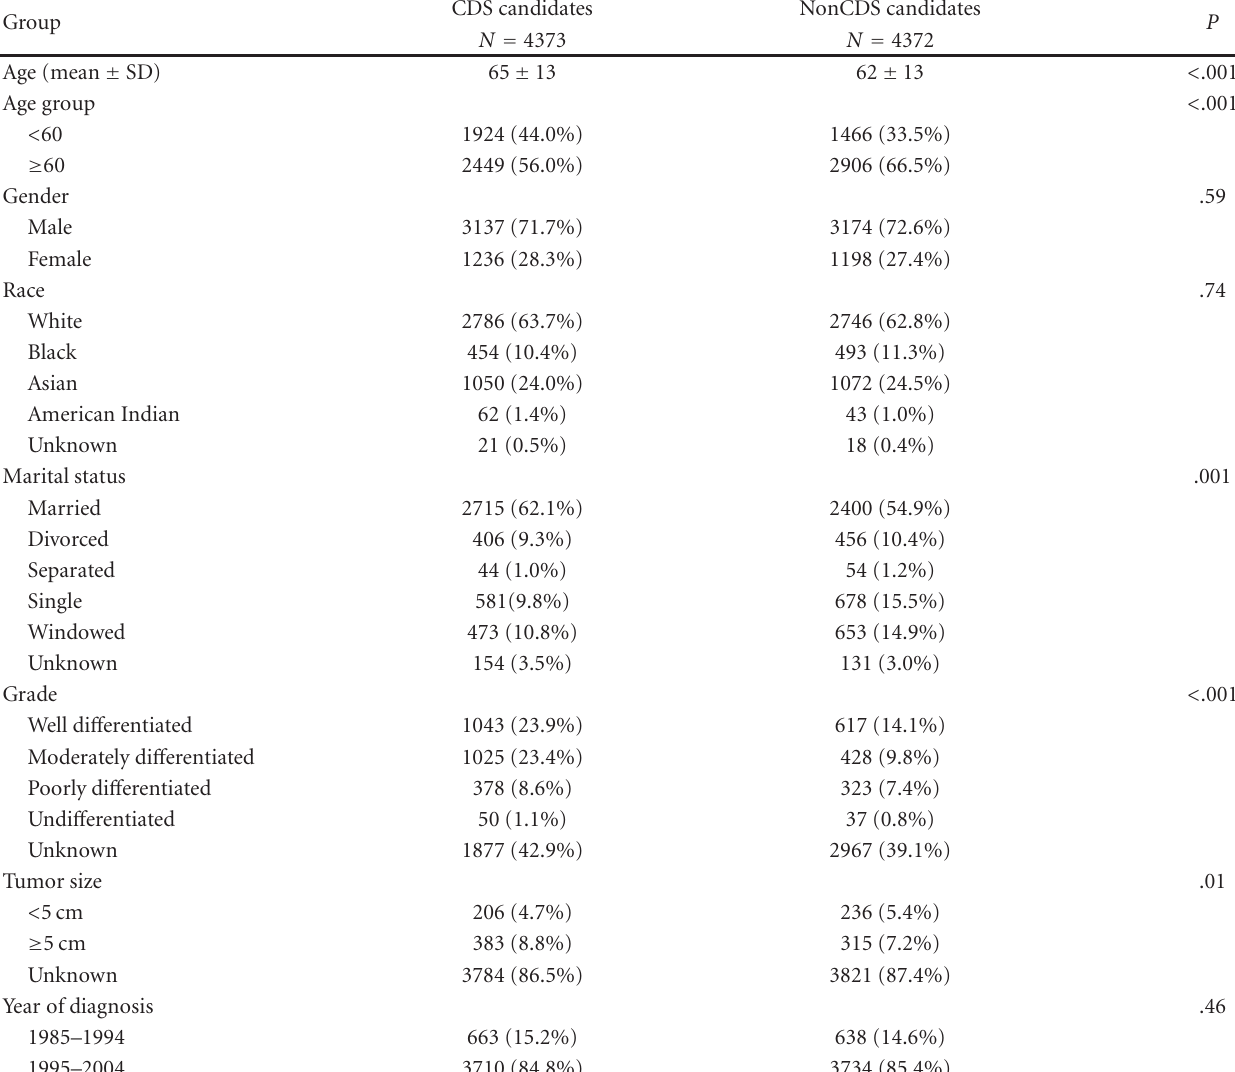
Table 1: Demographic and clinical characteristics of patients with localized HCC. CDS: cancer-directed surgery.